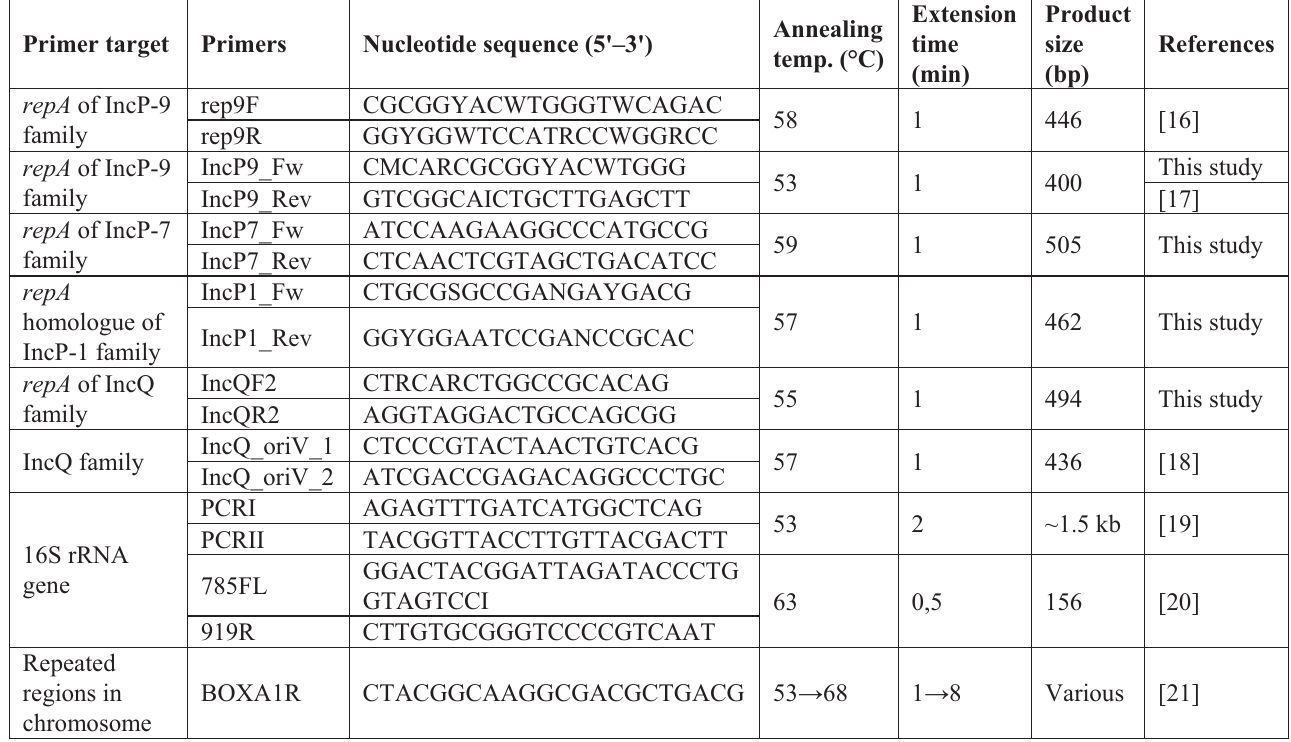
Table 1. PCR primers used in the